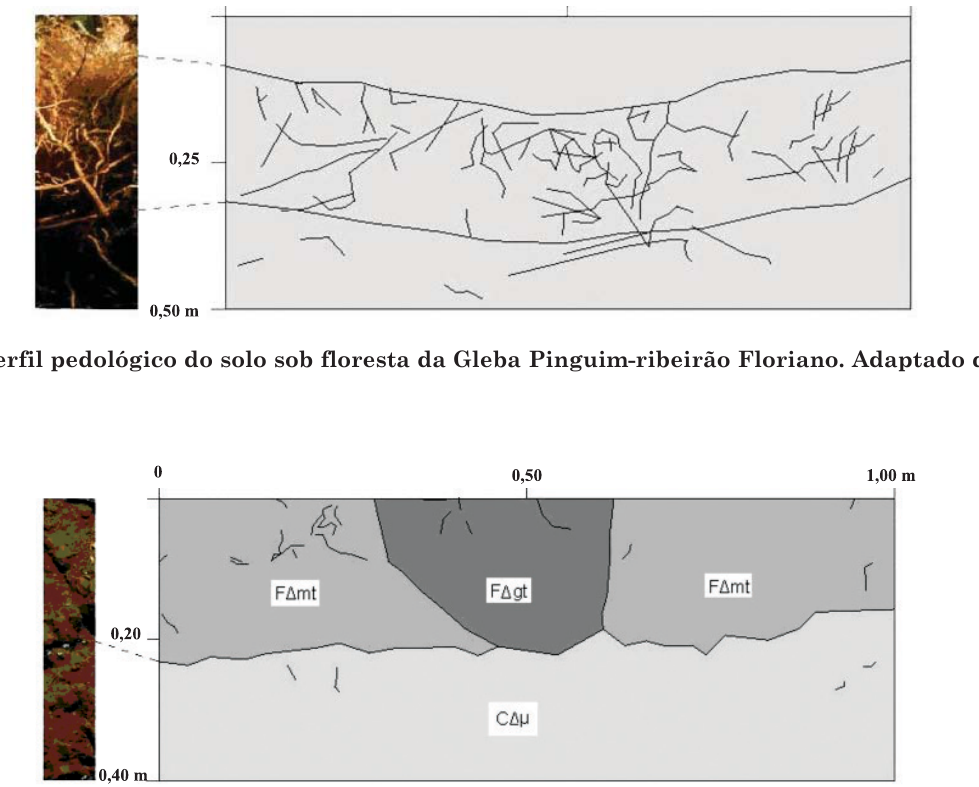
Figura 2. Perfil cultural do solo sob plantio convencional. F ΔΔΔΔΔ mt: em processo de compactação, com fissuras – médios torrões; F ΔΔΔΔΔ gt: em processo de compactação, com fissuras – grandes torrões; C ΔΔΔΔΔ μ (em processo de compactação,